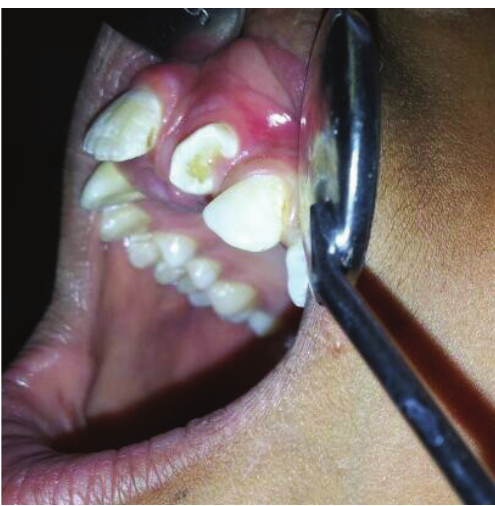
Figure 2: Clinical picture showing the lateral aspects of mesiodens.